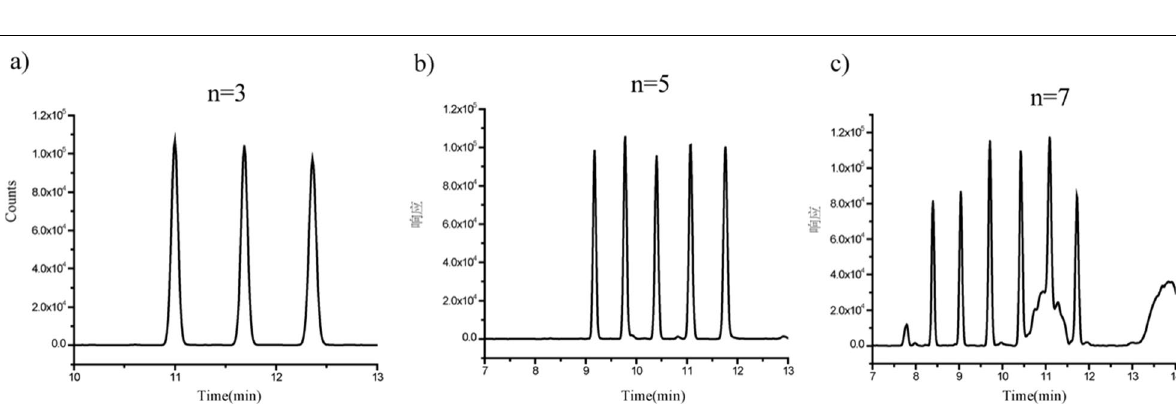
3, b n 5, c n 7, respectively, taking Cys as an = = =